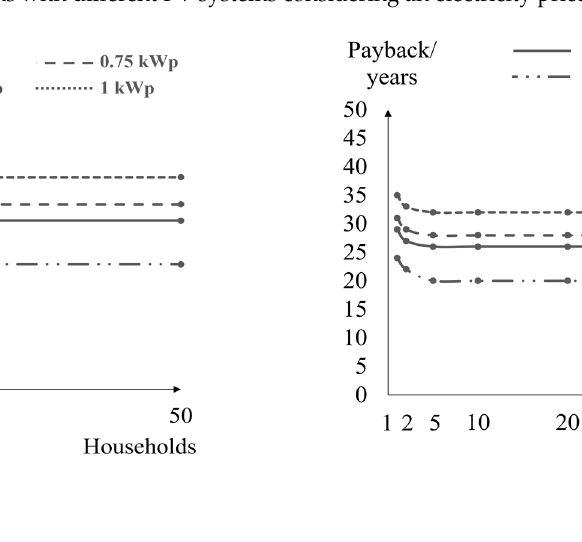
Figure 9. ( a ) Average household profitability in different combinations with different PV systems considering an electricity price growth of 2%; ( b ) average household profitability in different combinations with different PV systems considering an electricity price growth of 3%.